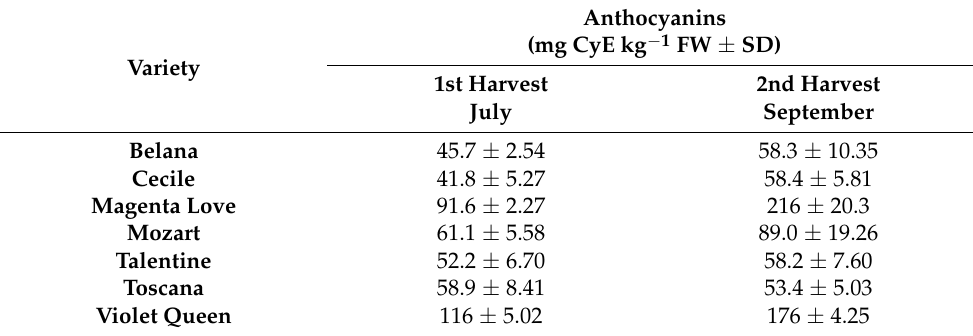
Table 2. Total anthocyanin contents in seven potato varieties depending on variety and harvesting pe-